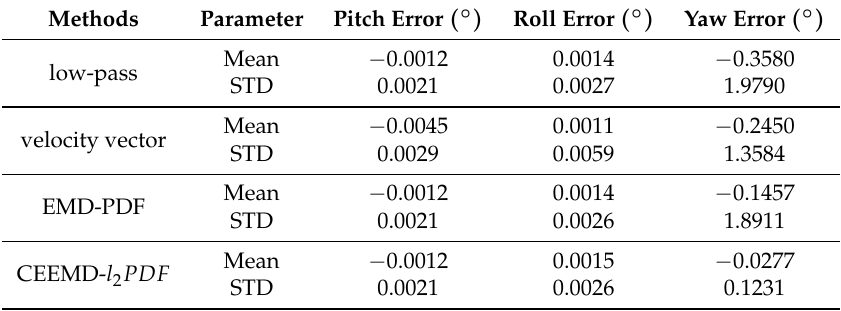
Table 3. Means and STDs of the alignment errors in the